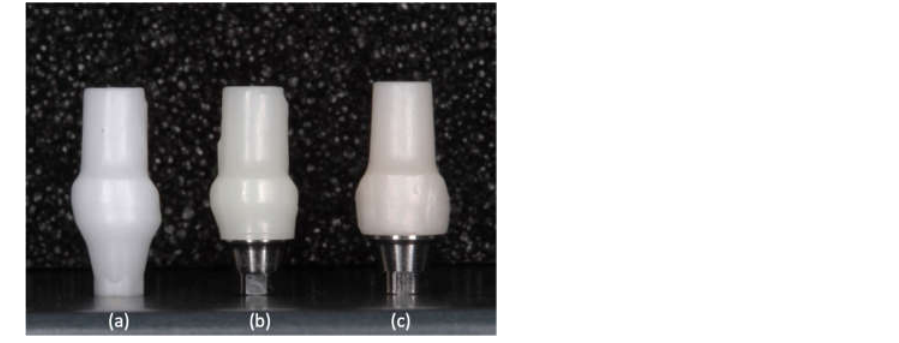
Figure 3. Three groups of zirconia abutments used: All-Zr (a), ASC-Zr (b), and AM-Zr abutments (c).